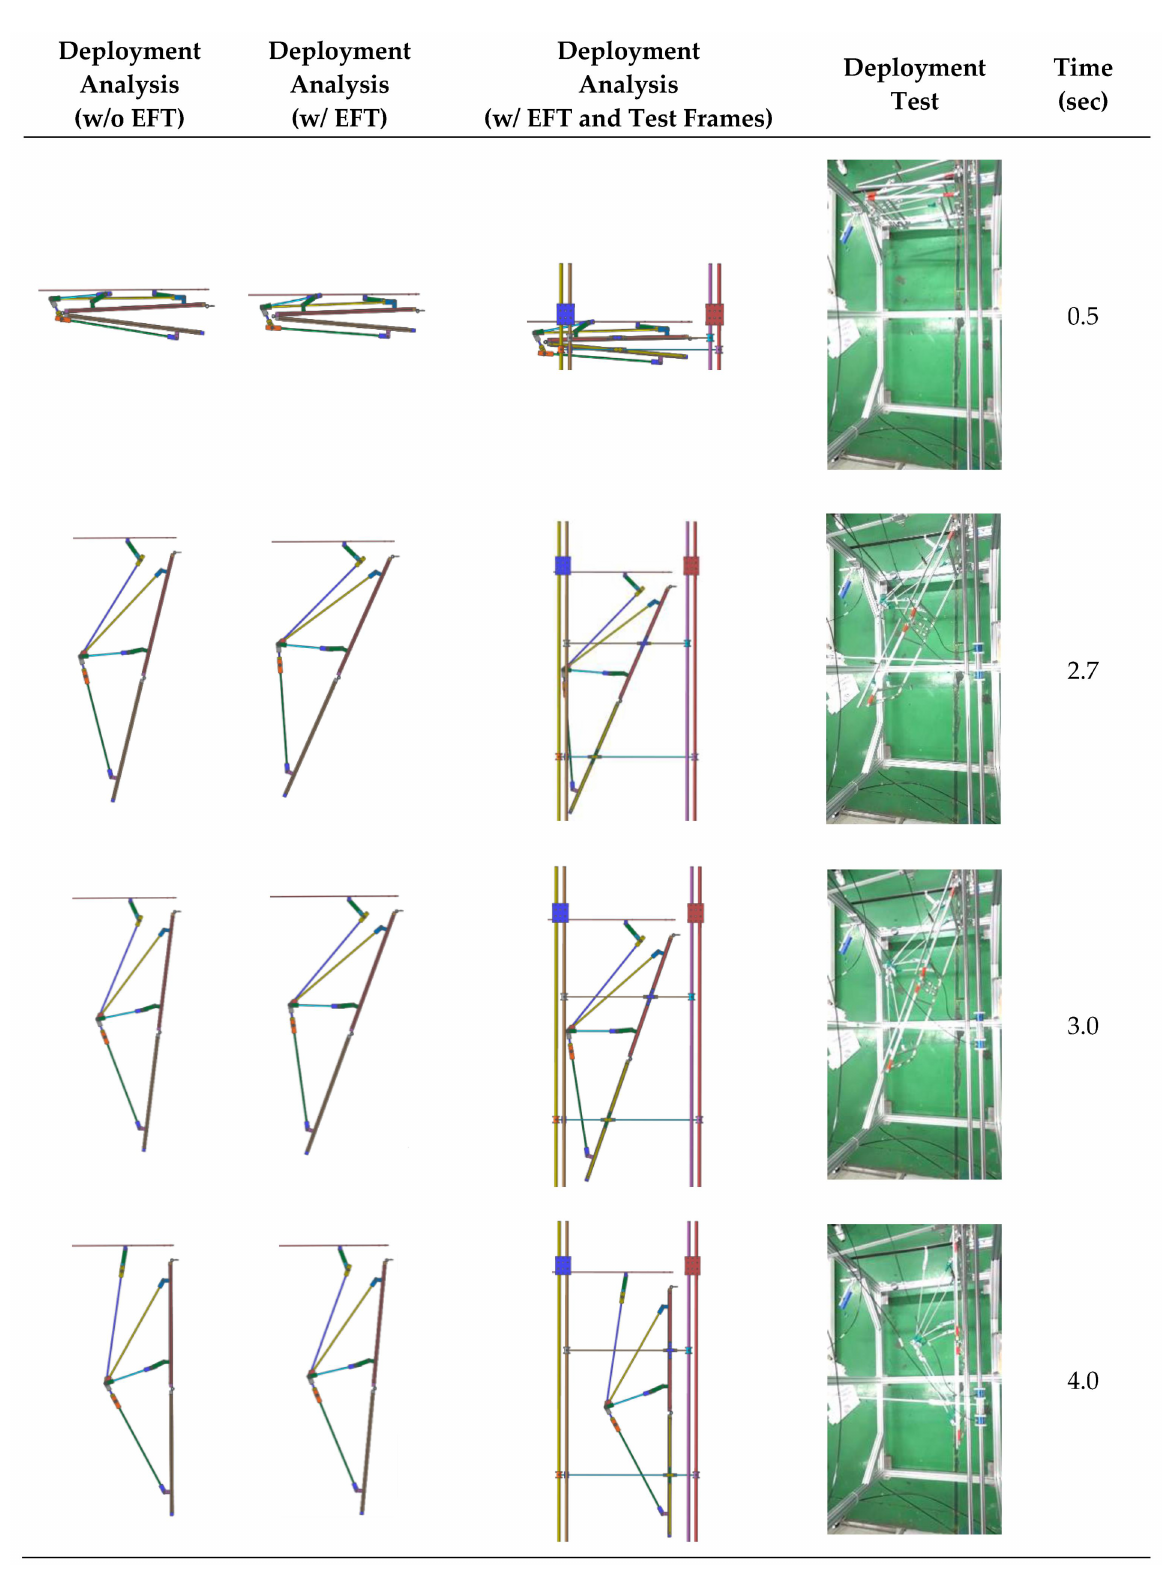
Figure 13. Comparison of the deployed motion history for case 2.